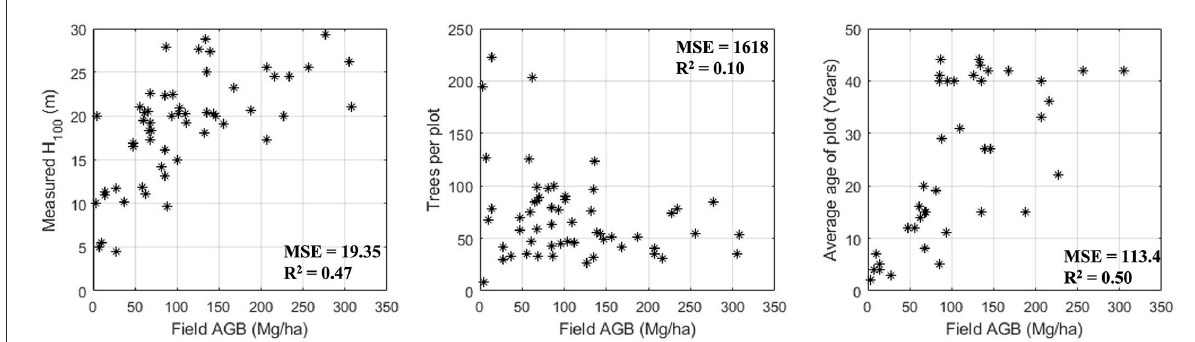
FIGURE2 Field campaign statistics: Forest mensuration height H 100 , trees per plot, and the average age of the plot are shown as a function of field measured AGB. The coefficient of determination ( R 2 ) and Mean Squared Error (MSE) for a logarithmic regression between field measured AGB and the parameters on the ordinate are also shown in the plots.